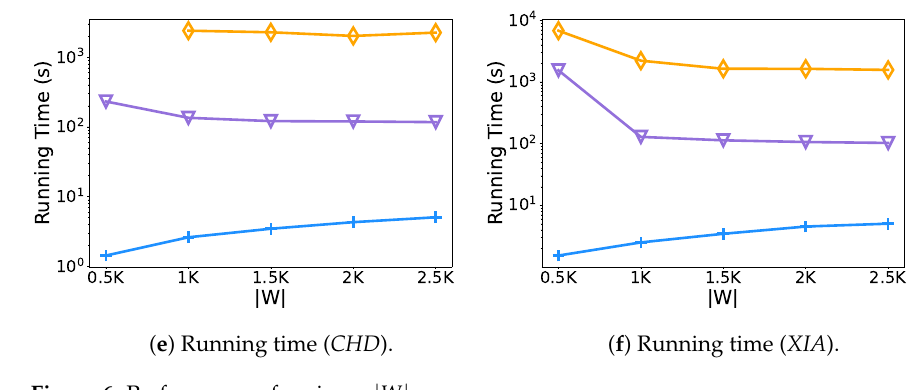
Figure 6. Performance of variance | W | .